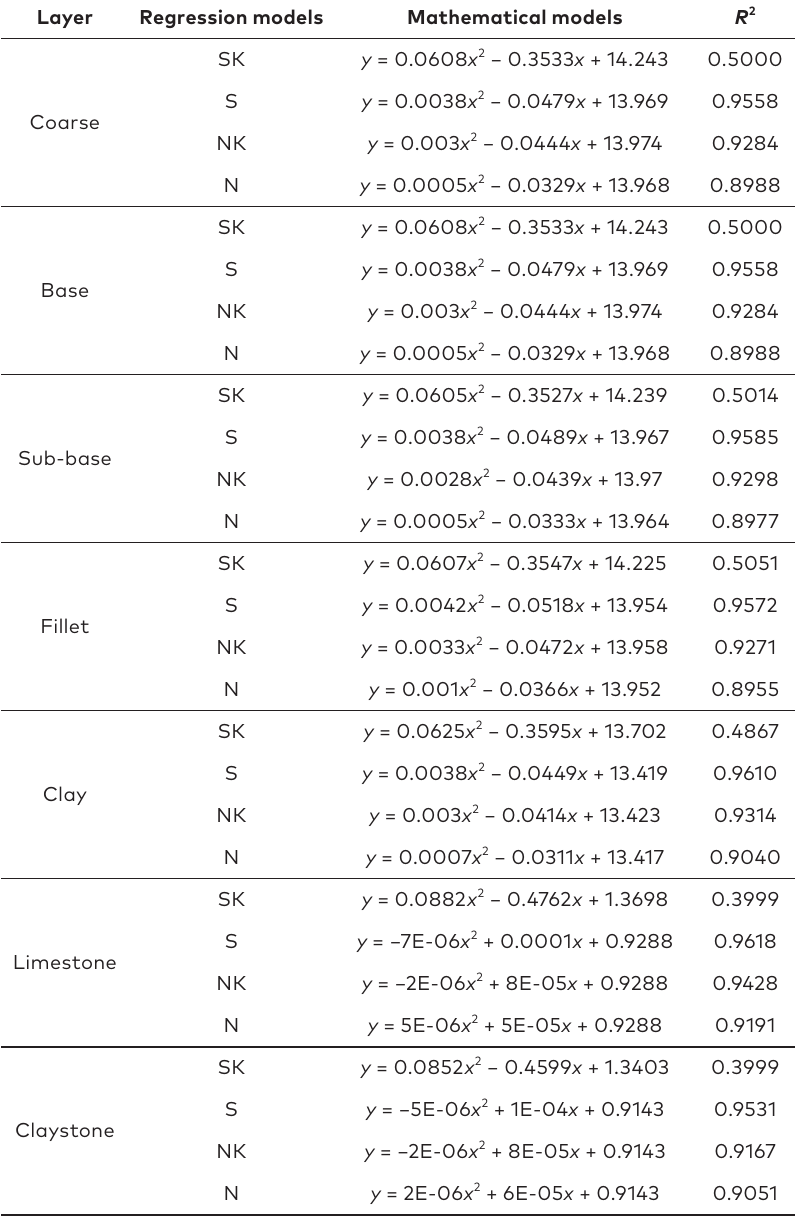
Table 12. Function and regression analyses of the relationship between the superstructure and soil layers of the road vertical deformation ( Y )-Time